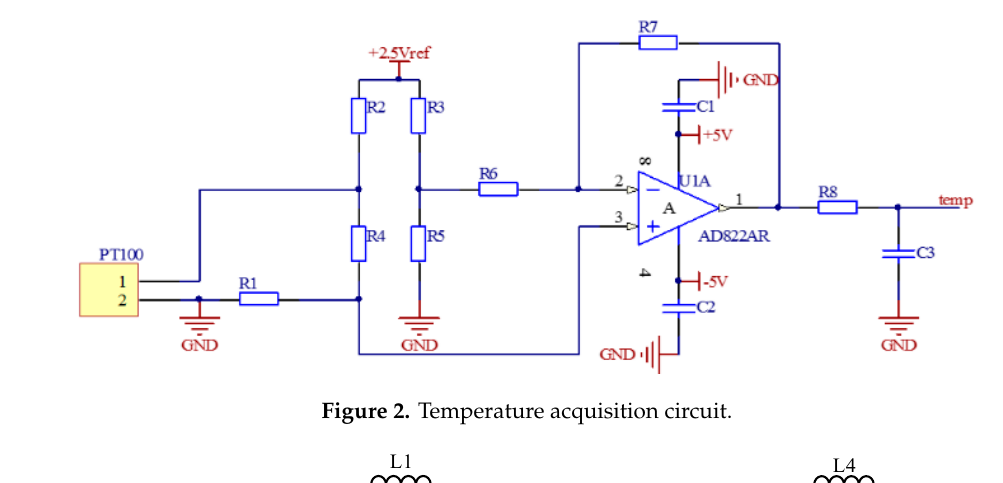
Figure 3. High frequency oscillator circuit.